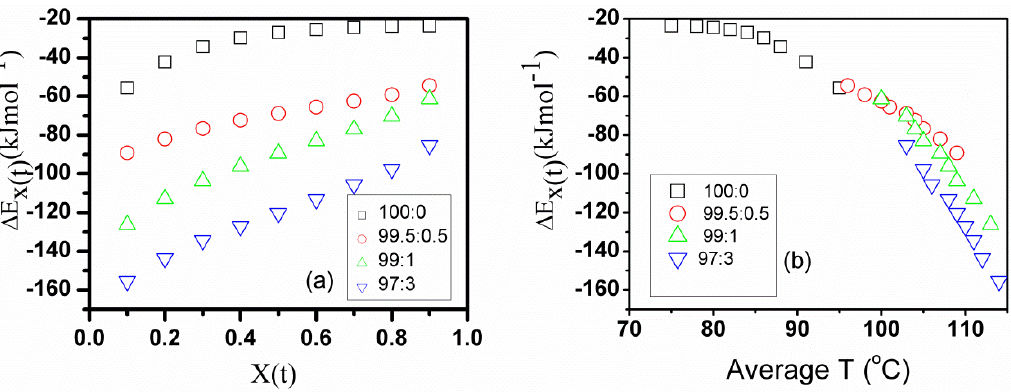
Figure 11. Dependence of the effective activation energy of the pure PHB and PHB/CpFe + nanocomposites on ( a ) X(t) and ( b ) average temperature.